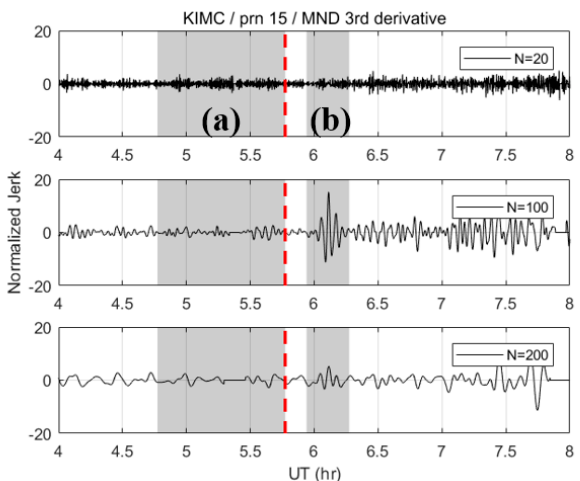
Figure 2. Normalized MND third derivatives with different N values: 20, 100, 200 (KIMC station, PRN 15) .